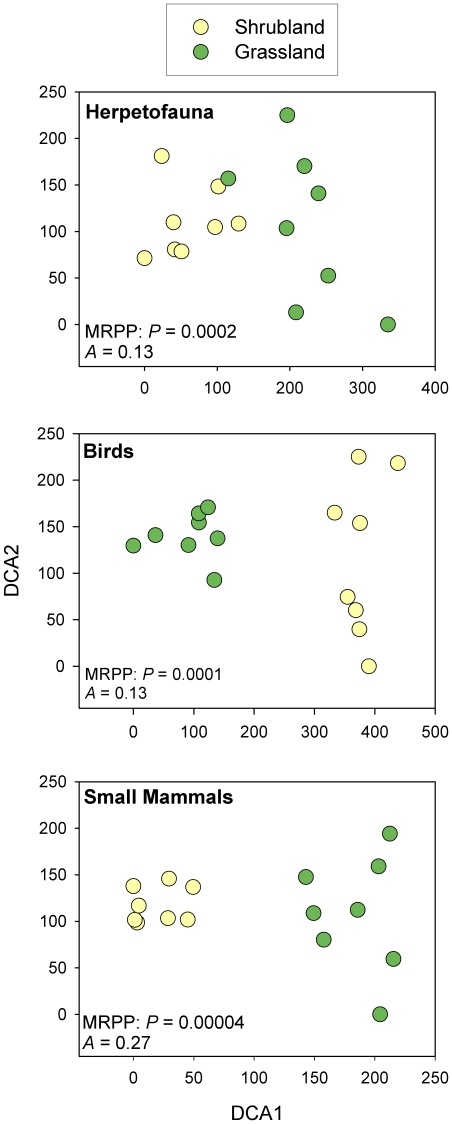
Total abundance of vertebrate species in grassland and shrubland habitats.Total abundance of herpetofauna, birds, small mammals, rabbits, and carnivores on the prairie dog grassland and shrubland habitats over all sample periods (1994, 1995, 1996, 2000, 2001, 2002; N = 8 for each sample period). Asterisks (*) indicate significant differences in abundance between the habiats at P<0.01.